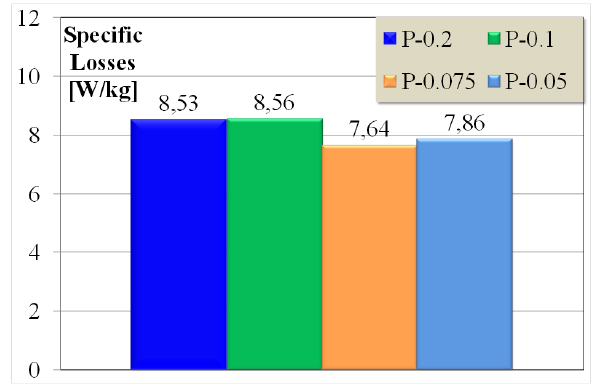
Figure 5: Specific iron losses for 50Hz @ 1T of phenolic samples